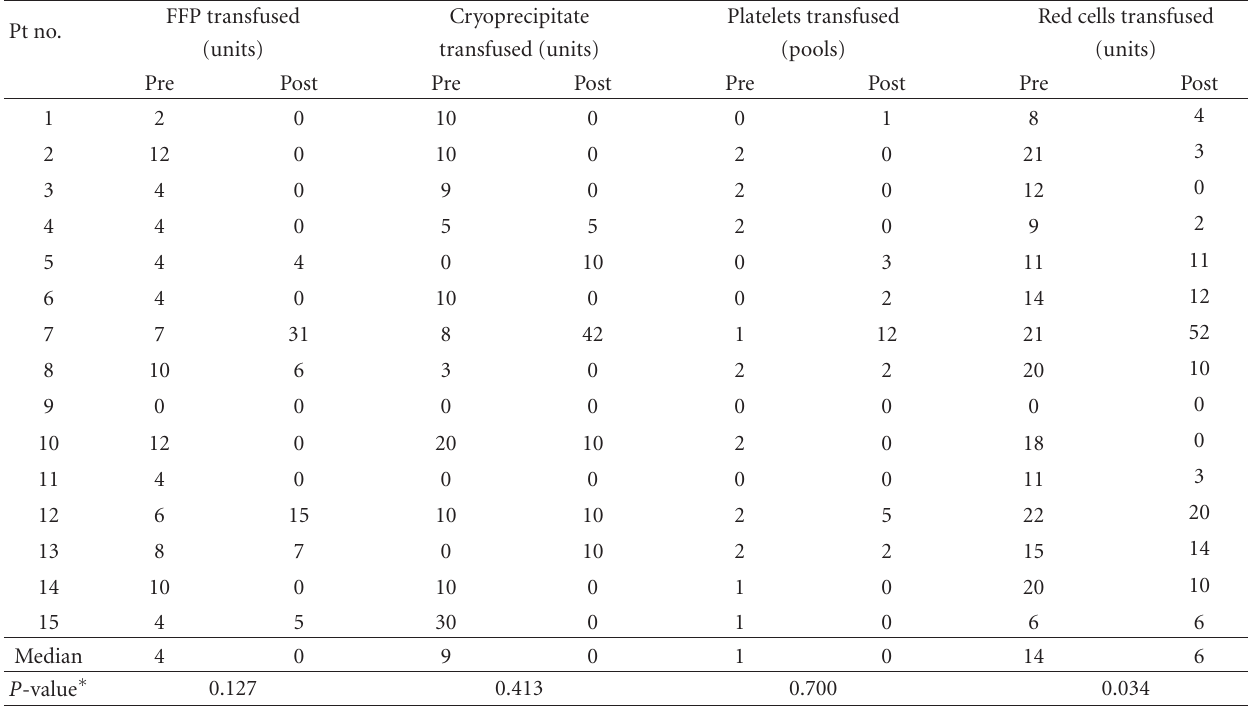
Table 2: Blood product requirements before and after the administration of rFVIIa for major obstetric haemorrhage. Pt no.